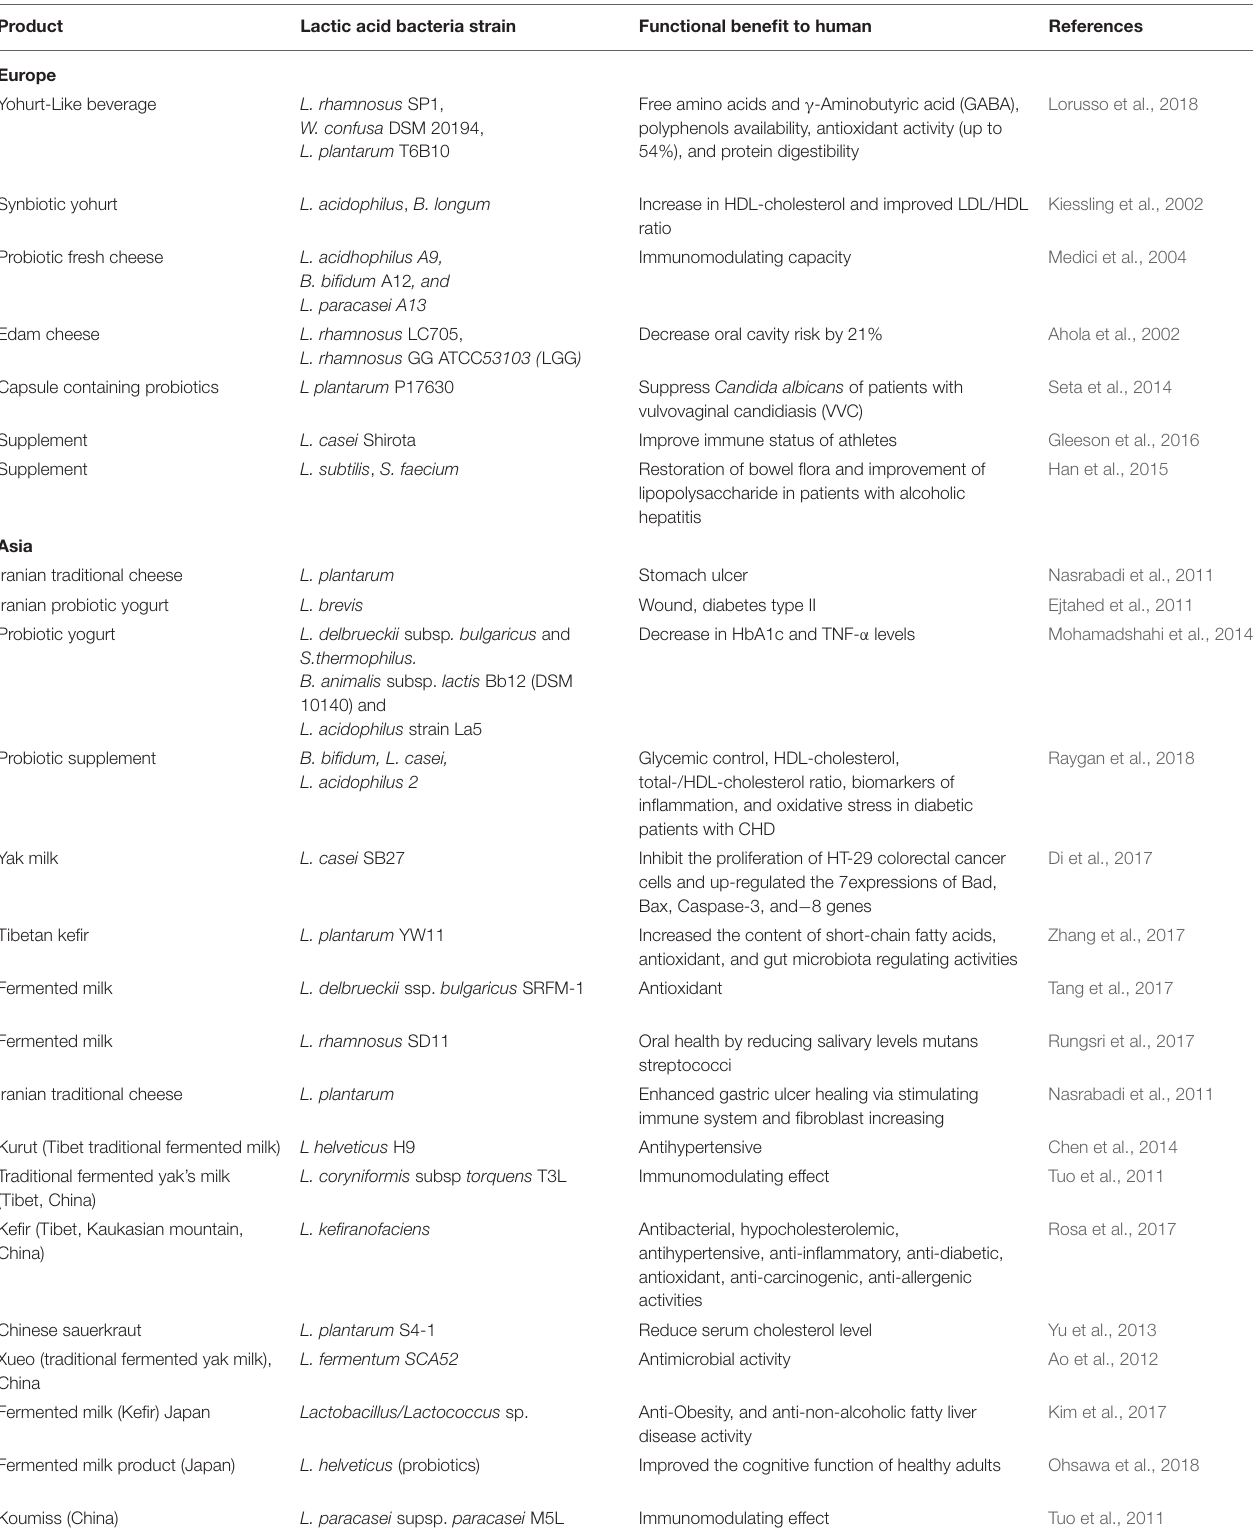
TABLE 1 | Beneficial effect of probiotic dairy products to human